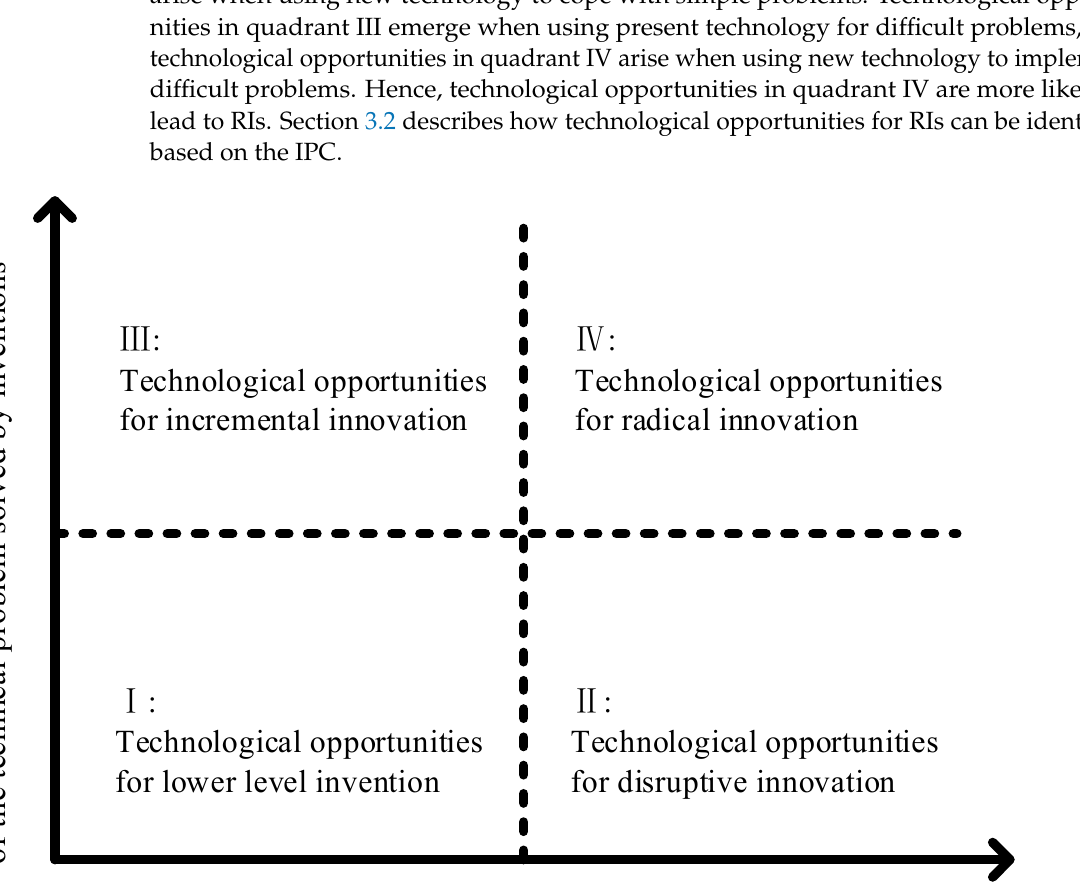
Figure 1. Two-dimensional coordinate system for classifying different technological opportunities.